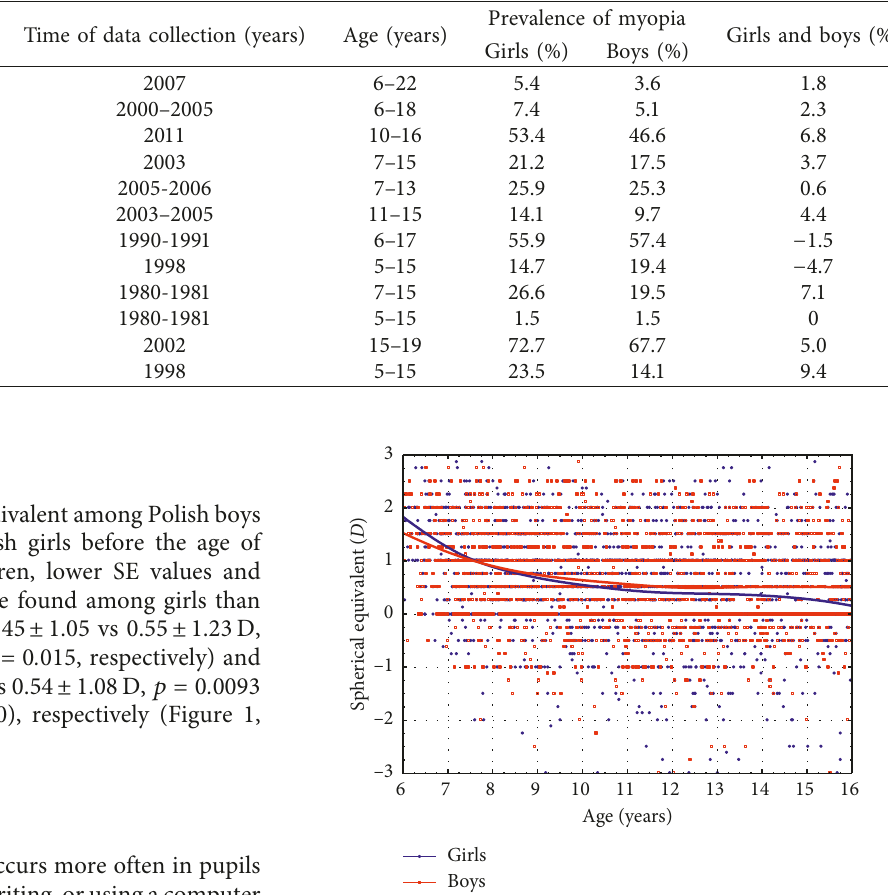
Table 1: Dependency between gender and myopia.